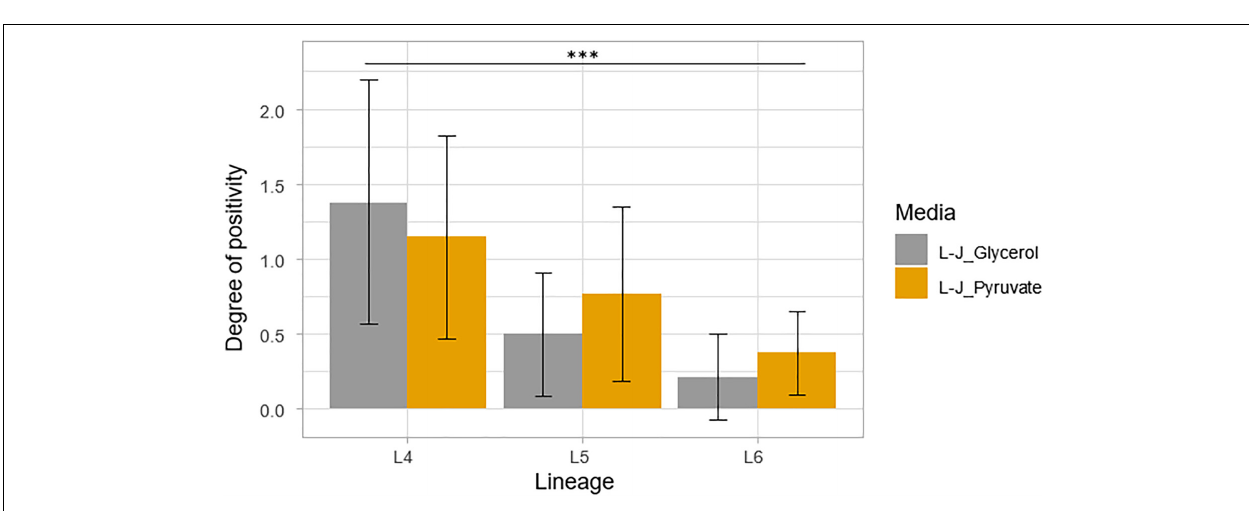
FIGURE 8 | Degree of culture positivity on L-J slants supplemented with either glycerol or pyruvate. Positivity was recorded at the same time as the TTP. Error bars were generated from the standard deviation